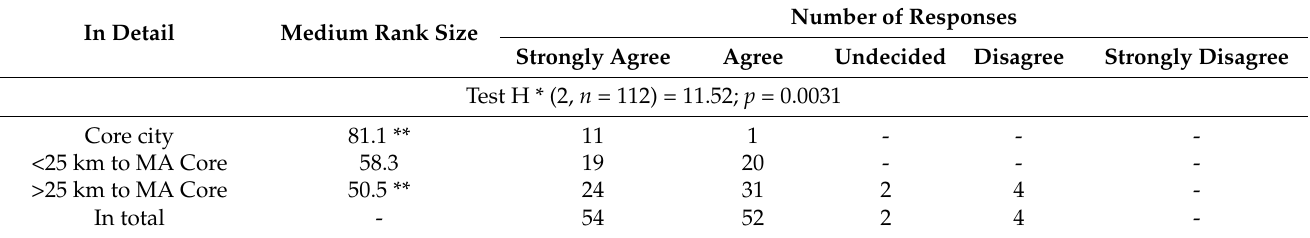
Table 13. Experts’ opinions on the process of reducing the number of livestock until 2027 ( n = 112). In